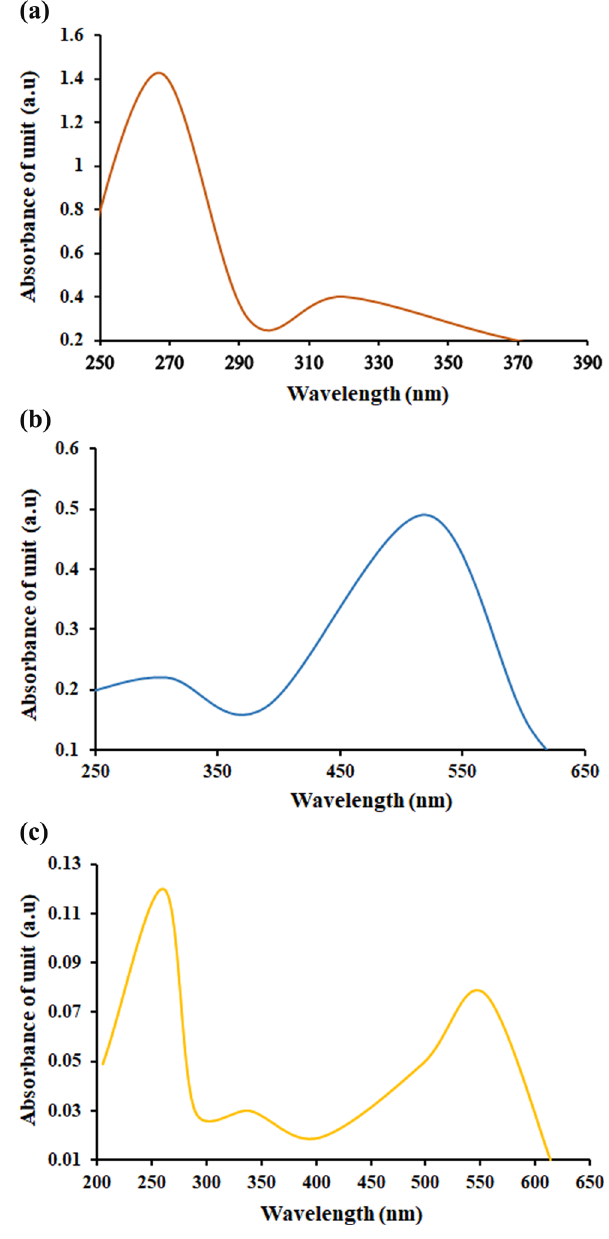
Figure 3: UV - Vis spectroscopic spectra: ( a ) AuNPs, ( b ) CHR, and ( c ) CHR –